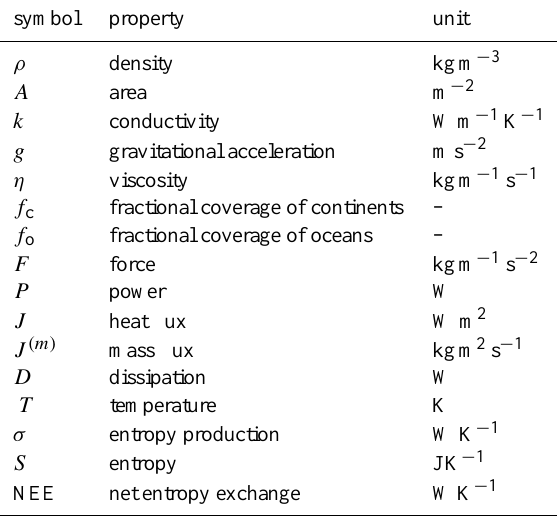
Table 1. Naming convention used in the model formulations. Table 2. Convention for the use of indices to identify subsystems as shown in Fig.